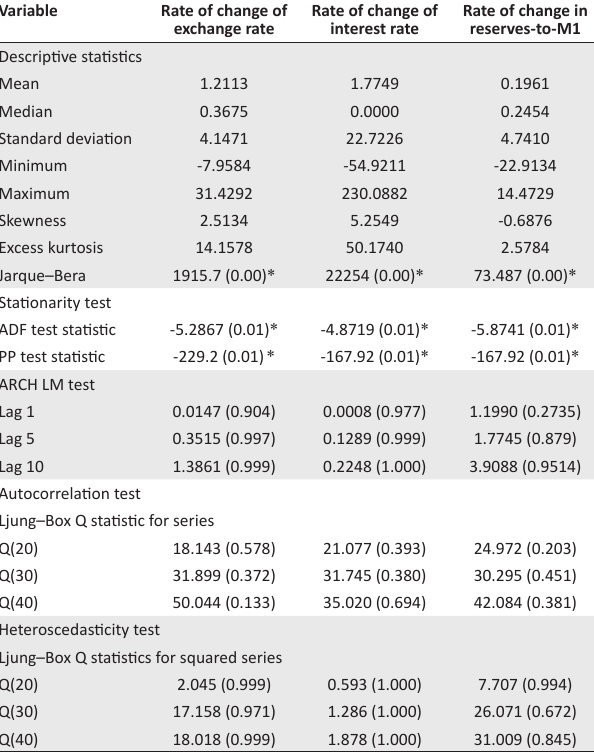
FIGURE 11: South Africa – Hill estimate to obtain cut-off between tail and central TABLE 9: Kenya – Descriptive statistics and time series tests of components of exchange market pressure.